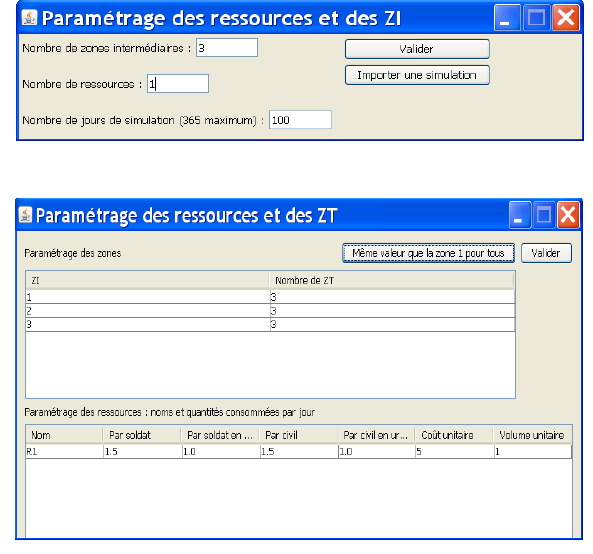
Fig. 4. Interfaces for parameters’